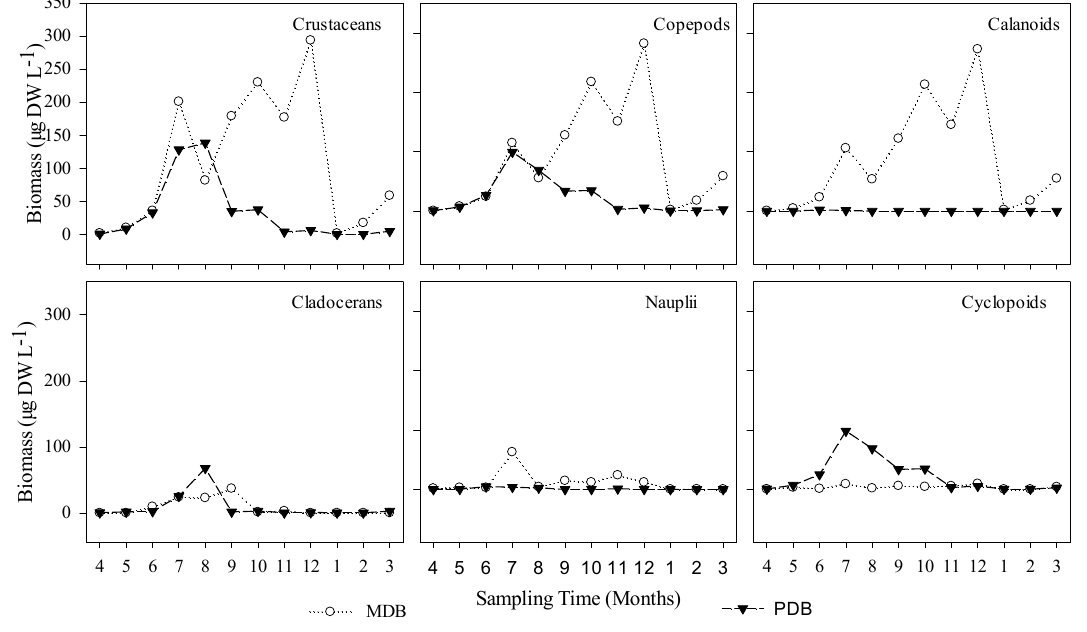
Figure A2. Biomass dynamics of crustacean zooplankton in MDB and PDB during the period April 2010–March 2011.